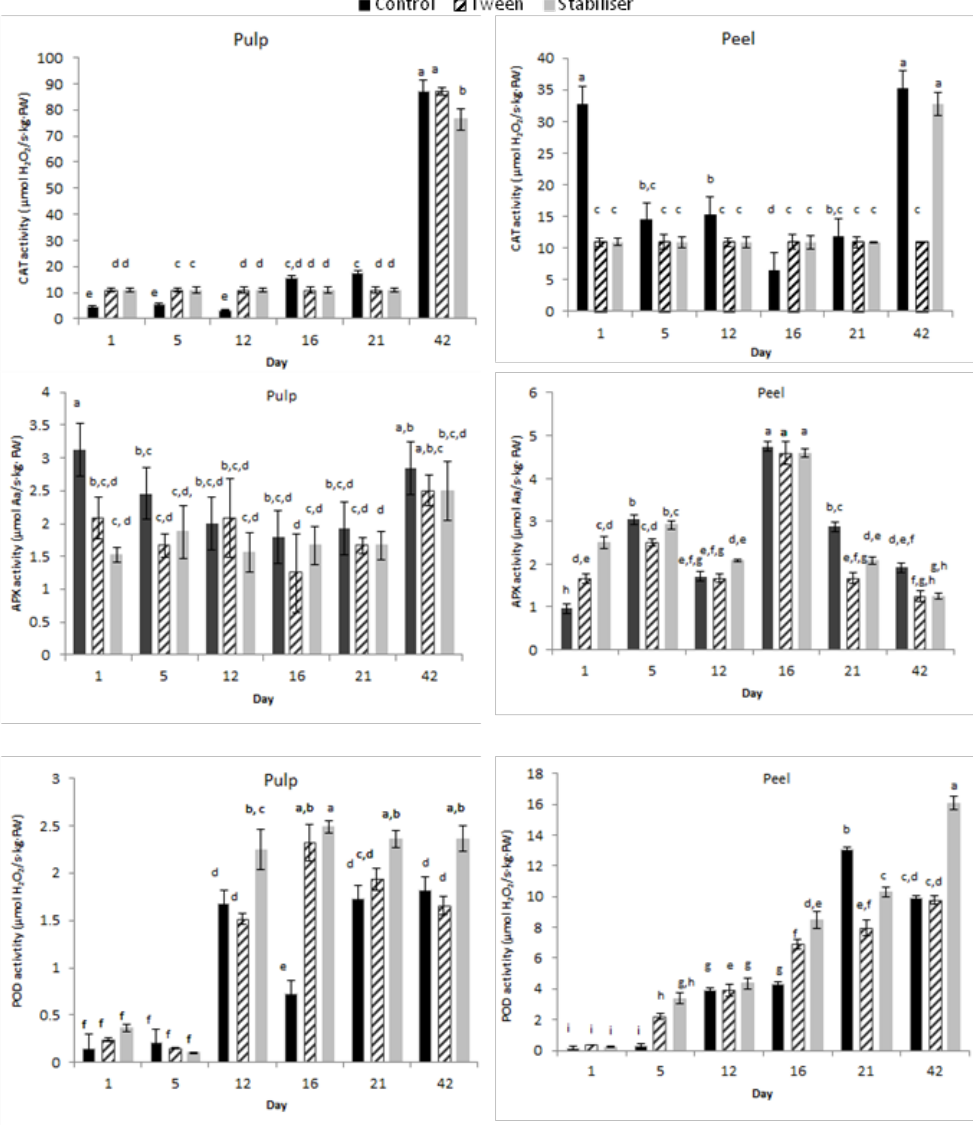
Figure 6. Catalase (CAT), ascorbate peroxidase (APX), and peroxidase (POD) activity in coated zucchini pulp and peel during six weeks of storage. The data are mean ± SD of three replicates from two zucchinis. Different letters indicate significant differences with ANOVA and Tuckey post-hoc test at p < 0.05.